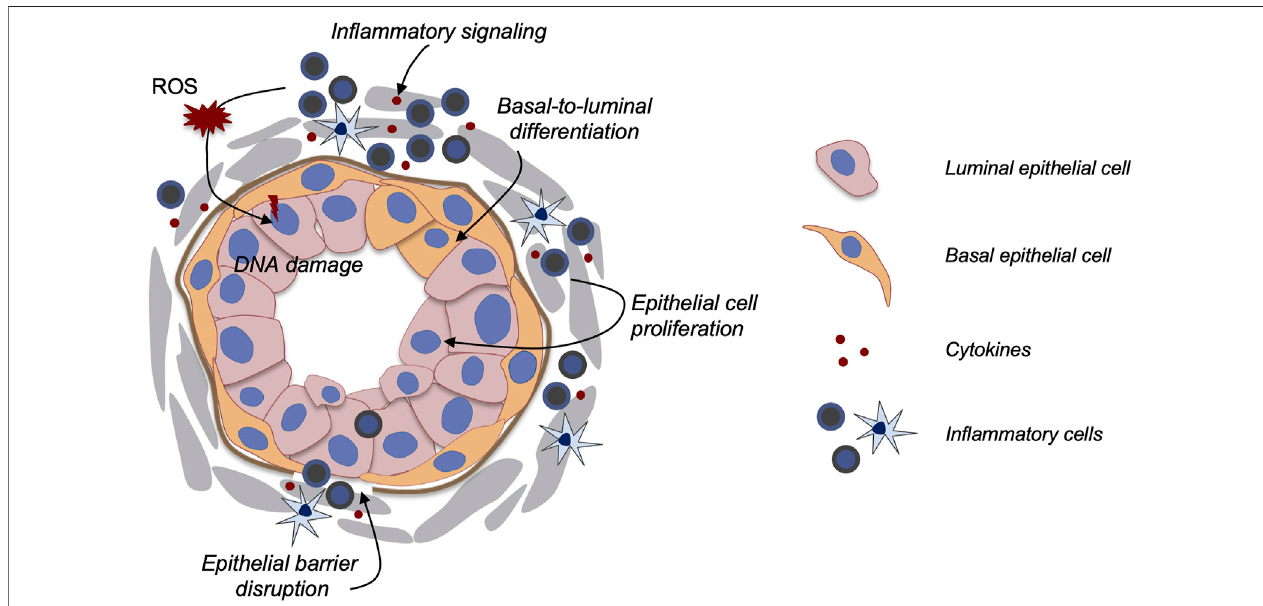
FIGURE 1 | Model of how prostatitis promotes PCa. Multiple possible mechanisms have been proposed as illustrated in the diagram. Secreted cytokines may promote epithelial cell proliferation, basal-to-luminal cell differentiation, and epithelial barrier disruption. In fl ammation-induced ROS production and Nkx3.1 down- regulation could also enhance DNA